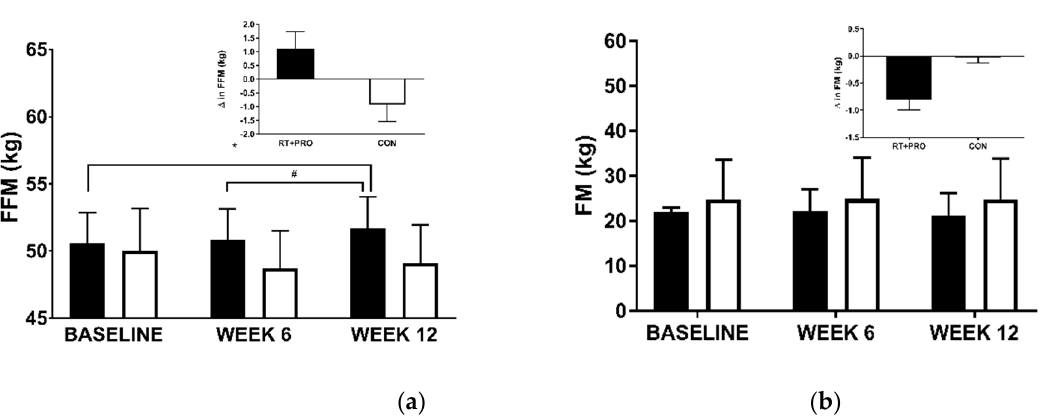
Figure 4. FFM ( a ) and FM ( b ) in CON (white bars; n = 20) and RT + PRO (black bars; n = 19) at baseline week, 6 and 12. An Asterisk (*) represents a significant difference from baseline to Week 12, a hashtag (#) represents differences from Week 6 to Week 12. The insert graph shows the change from baseline to Week 12. Values are presented as mean ± SE. FFM = Fat-free mass.